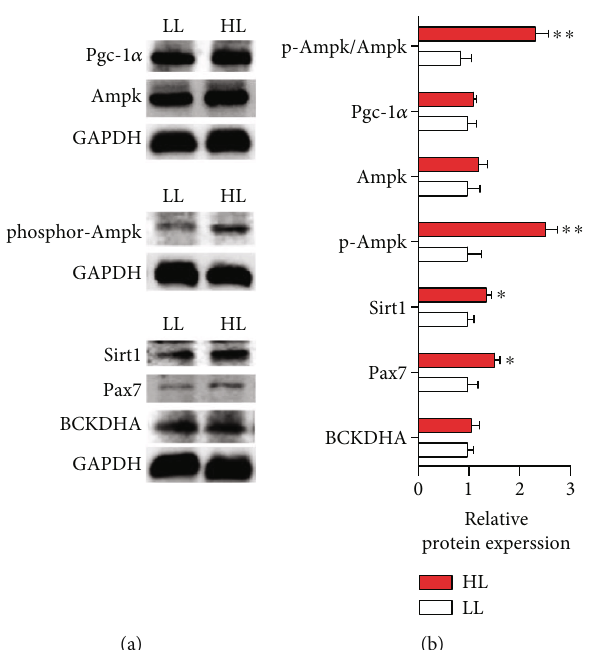
Figure 5: Western blot analysis of BCKDHA, Ampk, p-Ampk, Sirt1, Pgc-1 α , Pax7, p-Ampk/Ampk in the white muscle of blunt snout bream fed the two kinds of trial diets. Values are represented as mean ± SEM ( n = 4 ) by vertical bars. Values marked with asterisks are signi fi cantly di ff erent (Independent t -test, P < 0 : 05